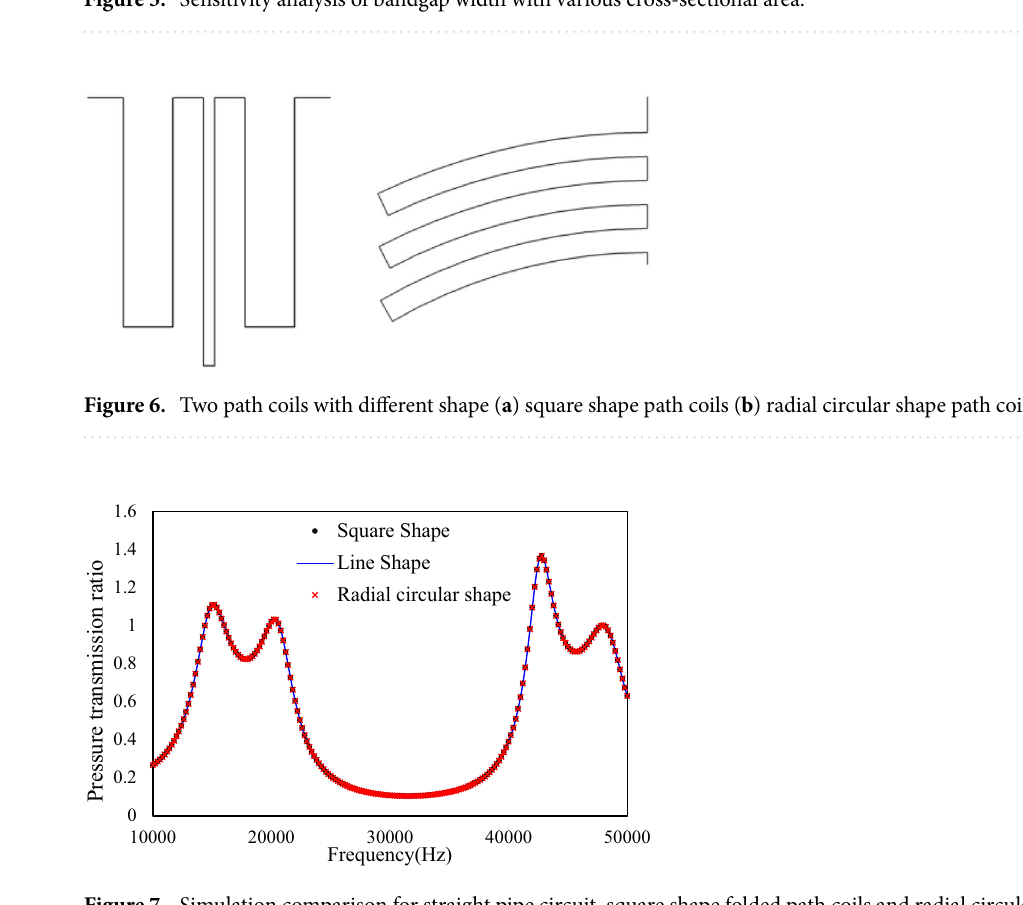
Figure 7. Simulation comparison for straight pipe circuit, square shape folded path coils and radial circular shape folded path